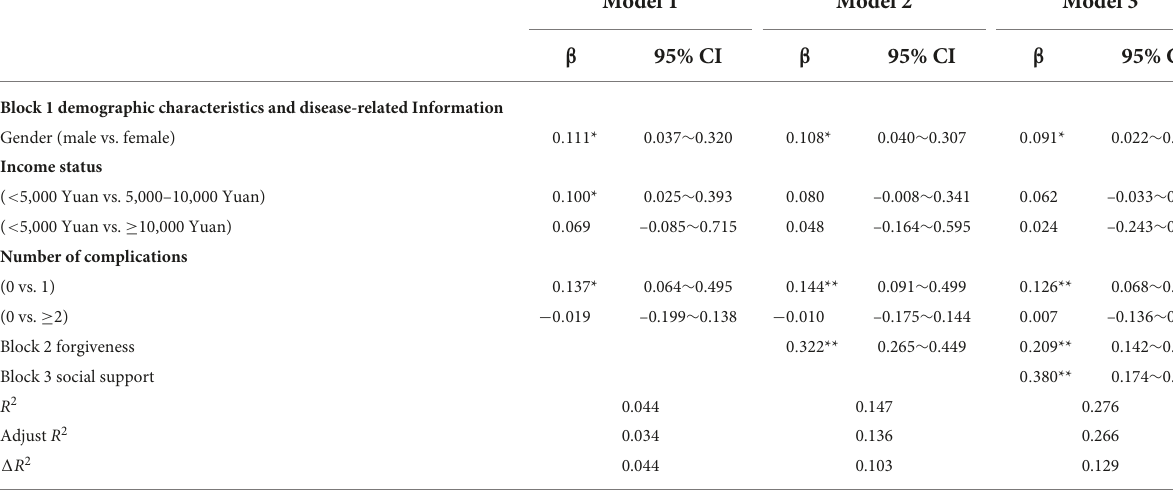
TABLE 3 The hierarchical multiple regression (HMR) models of post-traumatic growth (PTG).